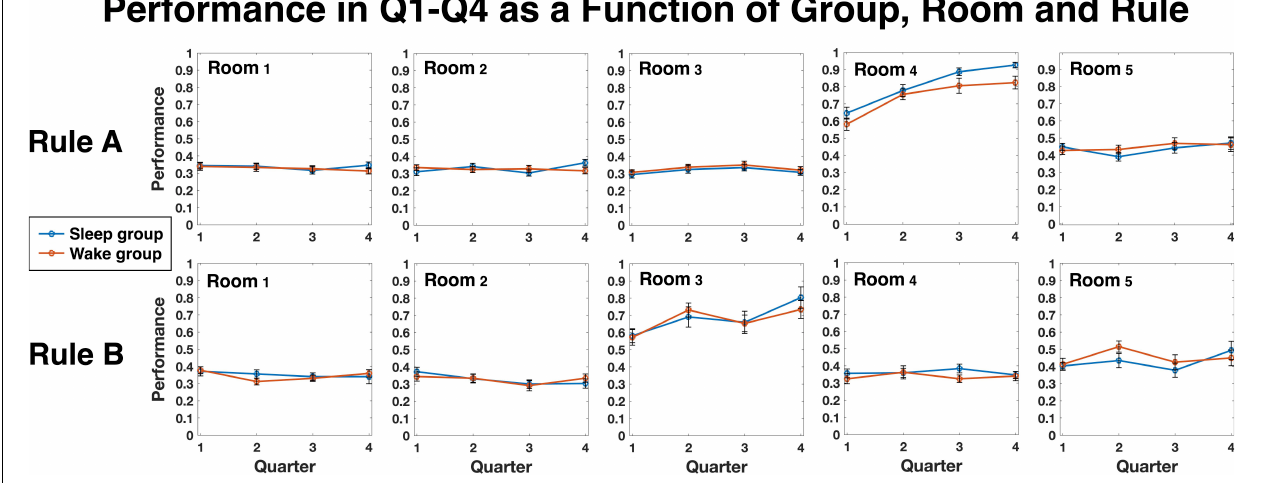
FIGURE 2 | Average performance in the task for each group, room and rule, separated to quartiles 1–4 (Q1–Q4). Each quartile represents 20 trials; quartiles 1, 2 are from Session 1 and quartiles 3, 4 are from Session 2.